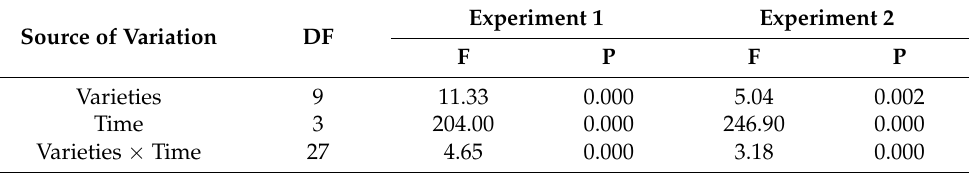
Table 2. Effect of variety and period of measurement on the wilting incidence in the screen house.